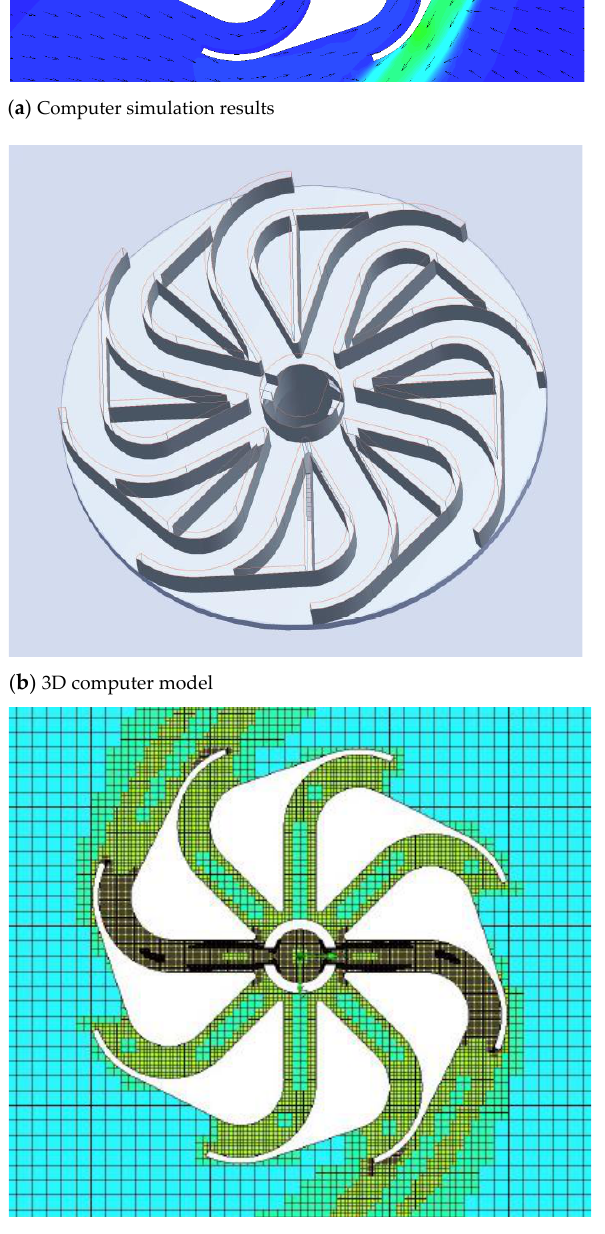
Figure 8. Computer simulation results for the turbine with a central nozzle diaphragm arrangement (Operation mode 1). Source: authors’ development. (Operation mode 1). Source: authors’